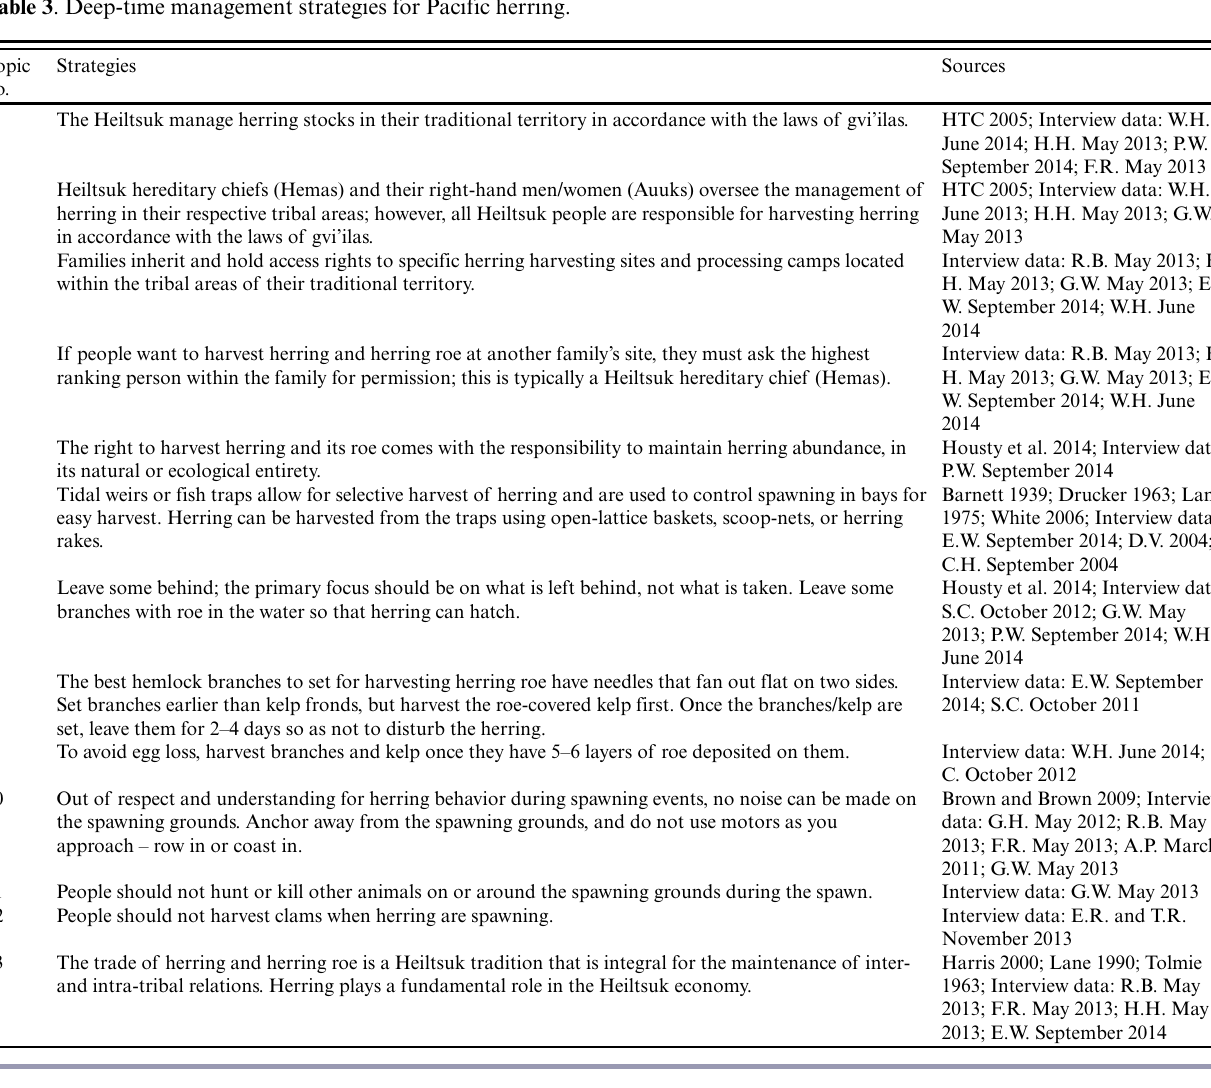
Table 3 . Deep-time management strategies for Pacific